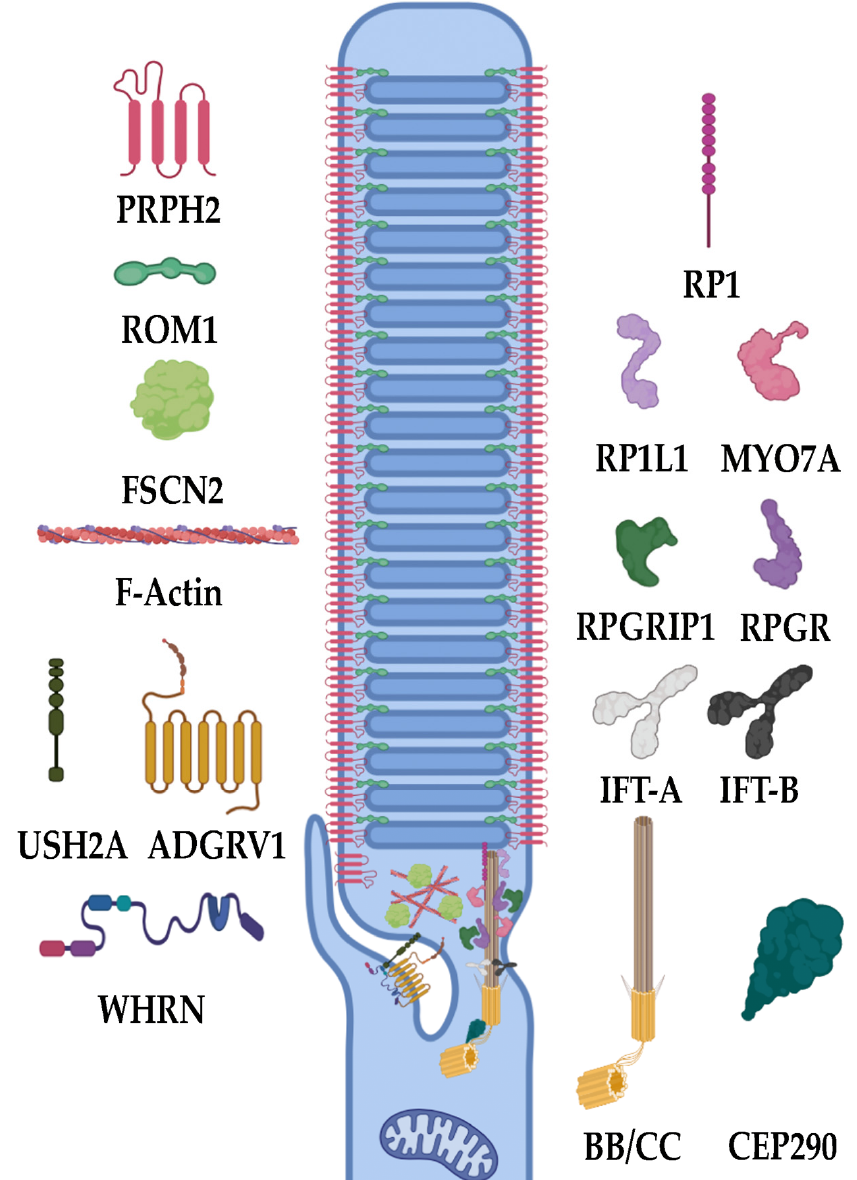
Figure 4. Diagram of ciliary and disc formation proteins. The connecting cilium (CC) forms from the basal body (BB), where CEP290 assists in tubulin nucleation. Trafficking protein complexes MYO7A, IFT-A, and IFT-B work to traffic important ciliary proteins and cargo anterograde and retrograde. Usher syndrome proteins USH2A, ADGRV1, and WHRN synergistically work to tether the periciliary ridge to the base of the outer segment. Ciliary proteins RPGR and RPGRIP1 work in concert to stabilize the CC, while RP1 and RP1L1 work to initiate the process of disc formation in the outer segment. Actin bundling protein FSCN2 works at the base of the outer segment to form F-actin bundles for disc formation to ensue by PRPH2 and ROM1, two of the major disc formation proteins tasked with flattening the circular vesicles into discs, a less energetically favorable